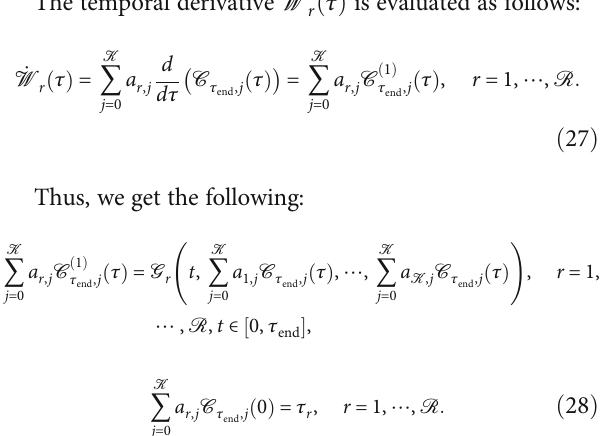
Table 2: Maximum absolute errors of Equation (35).